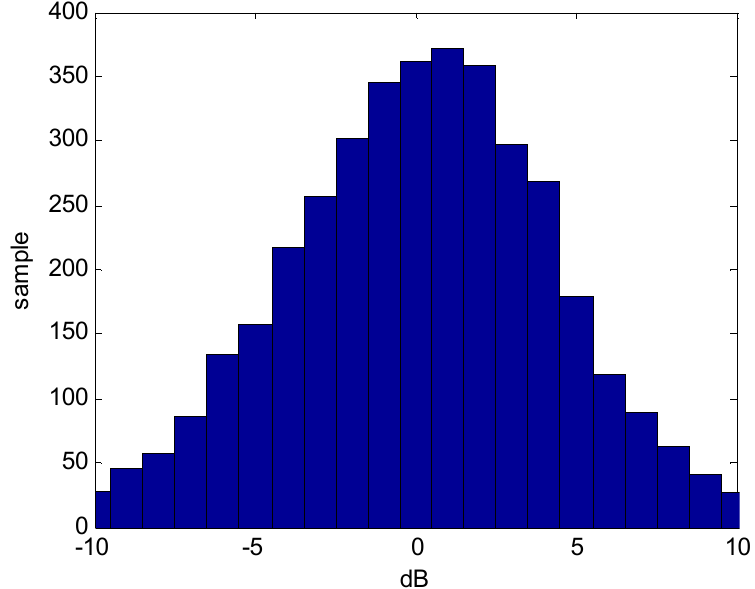
Figure 13. Histogram of the variation of RSS for combined temporal, antenna orientation and body position.